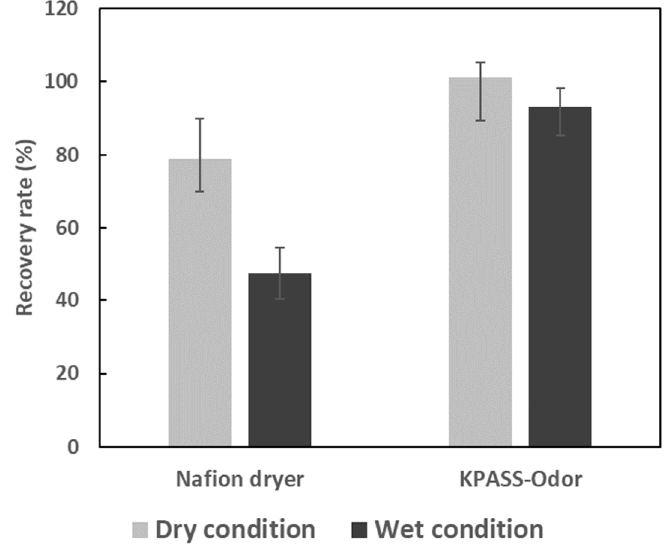
Figure 9. VOCs response of a PID sensor with respect to various moisture pretreatment devices and humidity conditions.